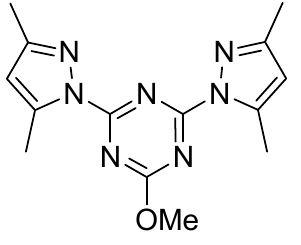
Figure 1. Structure of the BPMT ligand.